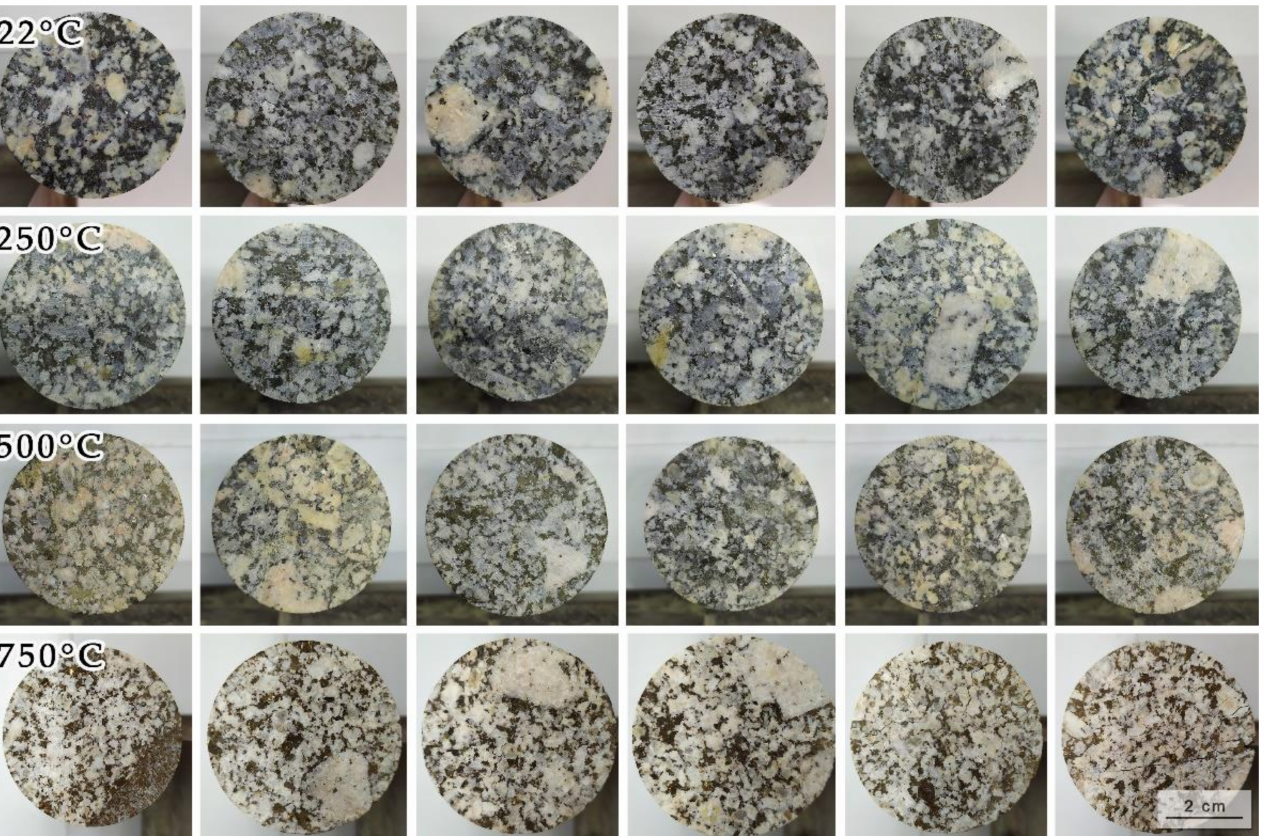
Figure 3. Texture and color change of heat-treated granite specimens. Samples representing the same temperature are shown in rows. Sample ID-s from left to right increase from 1 to